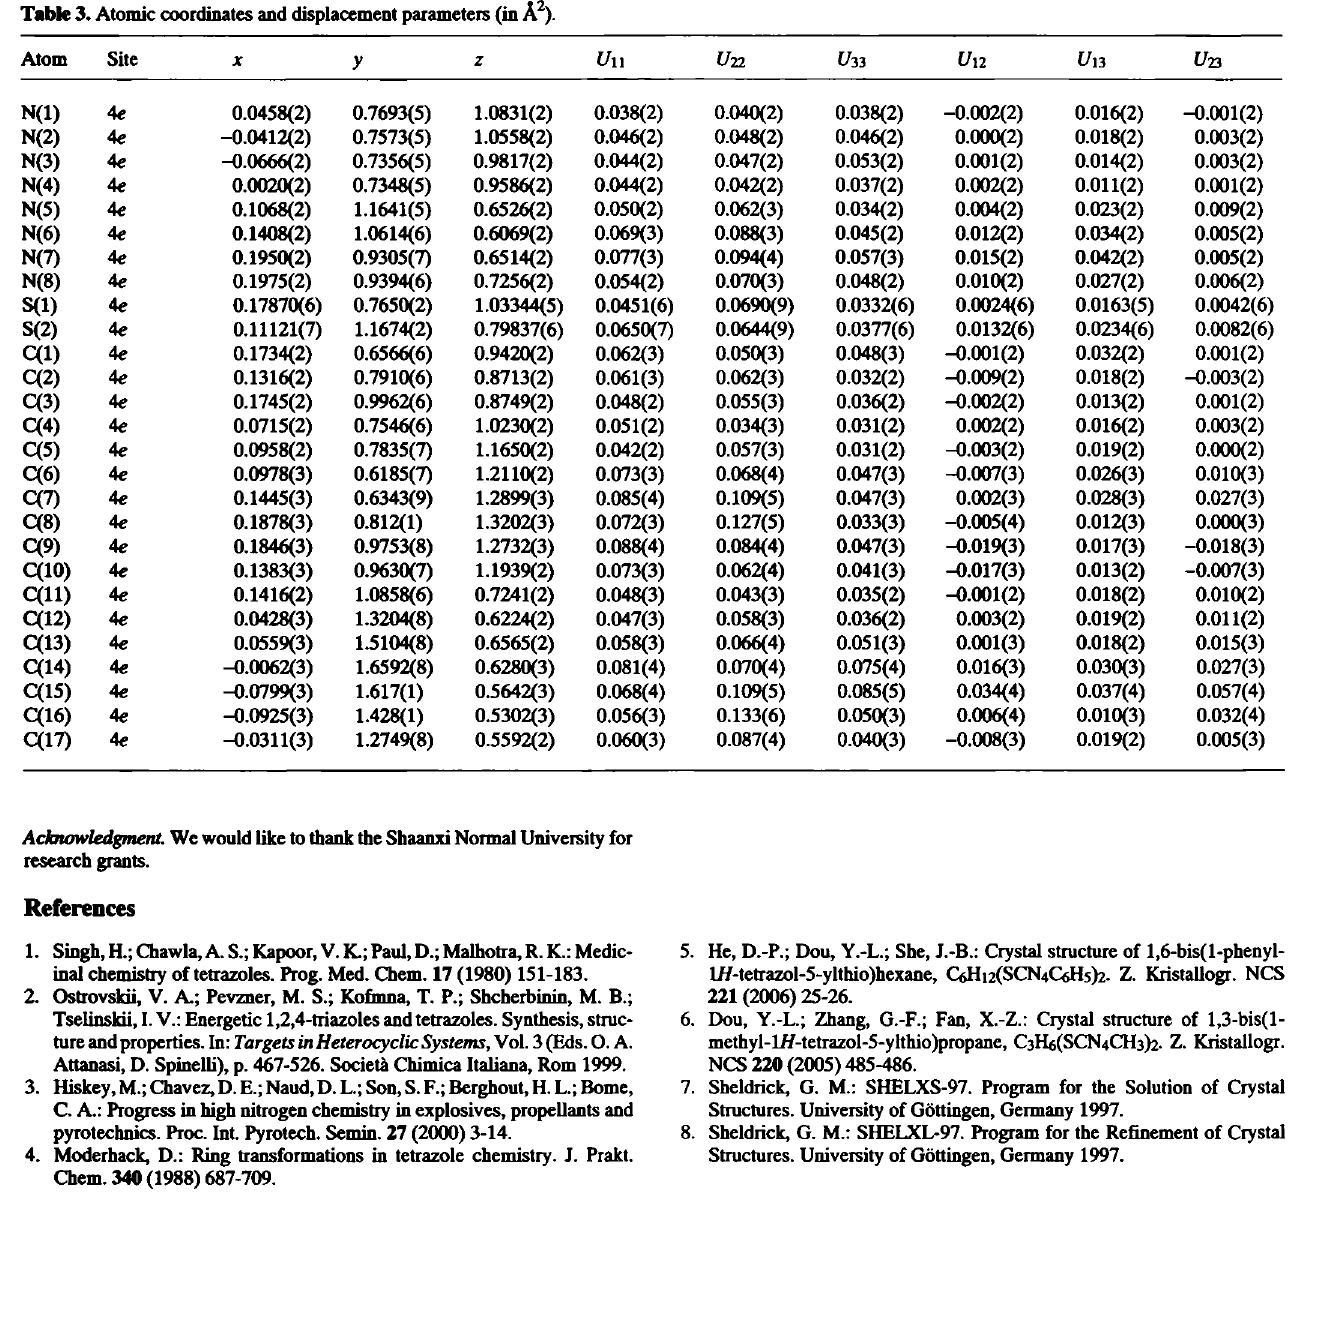
Table 3. Atomic coordinates and displacement parameters (in A 2